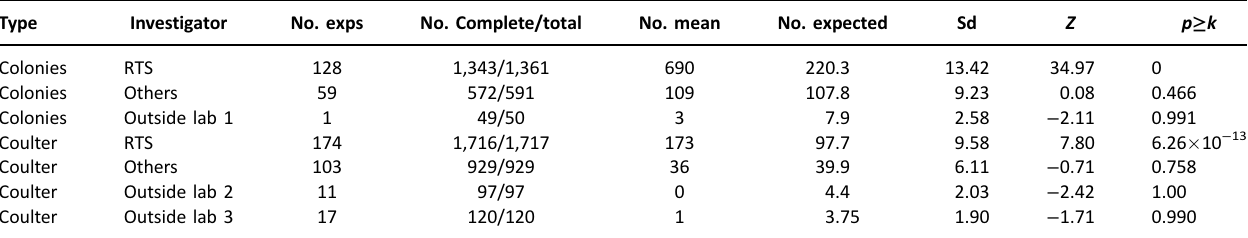
Table 2. Summary results for analysis of mean containing triples for colony and Coulter count triples from RTS, nine other investigators from the same lab, and investigators in outside